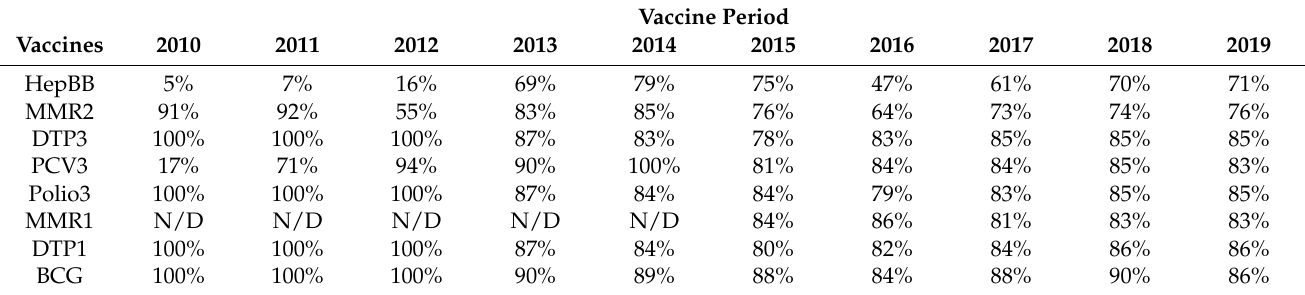
Table 1. Vaccination coverage (%) in Ecuador in the 2010–2019 period. Vaccine